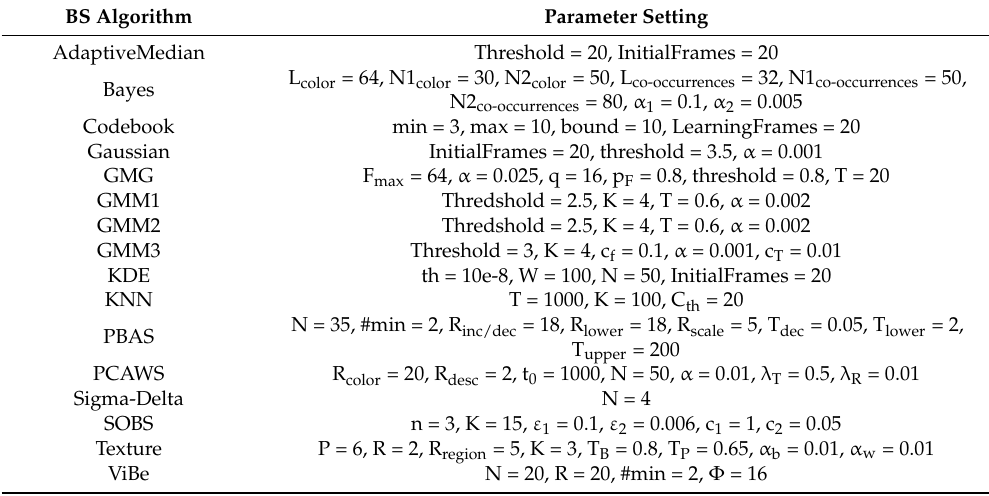
Table 6. Parameter settings of the evaluated BS algorithms. Table 8. Parameter settings of the evaluated BS algorithms.